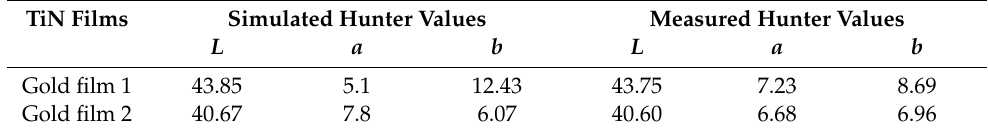
Table 4. Measured and simulated color values of TiN films.